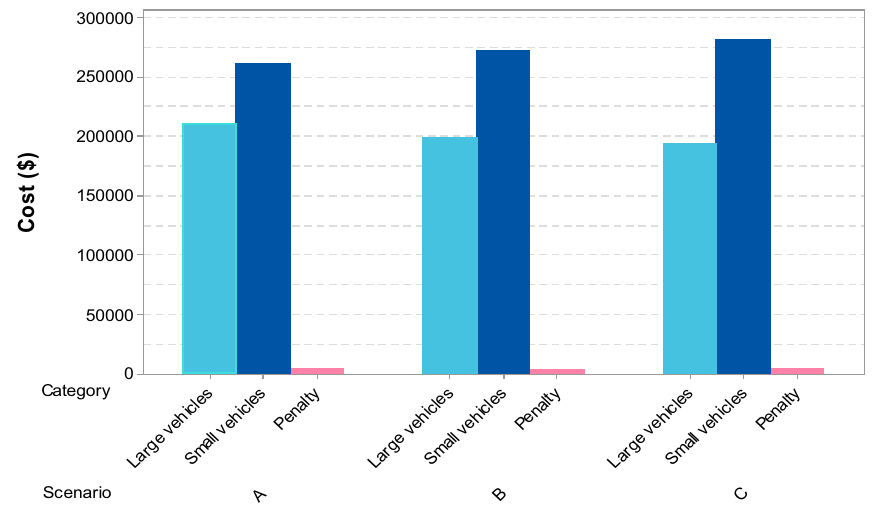
Figure 8. Transportation and penalty costs for the three